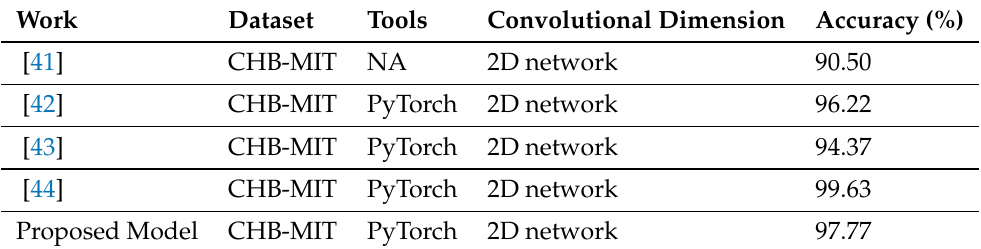
Table 14. Accuracy of some seizure detection methods on the CHB-MIT dataset.